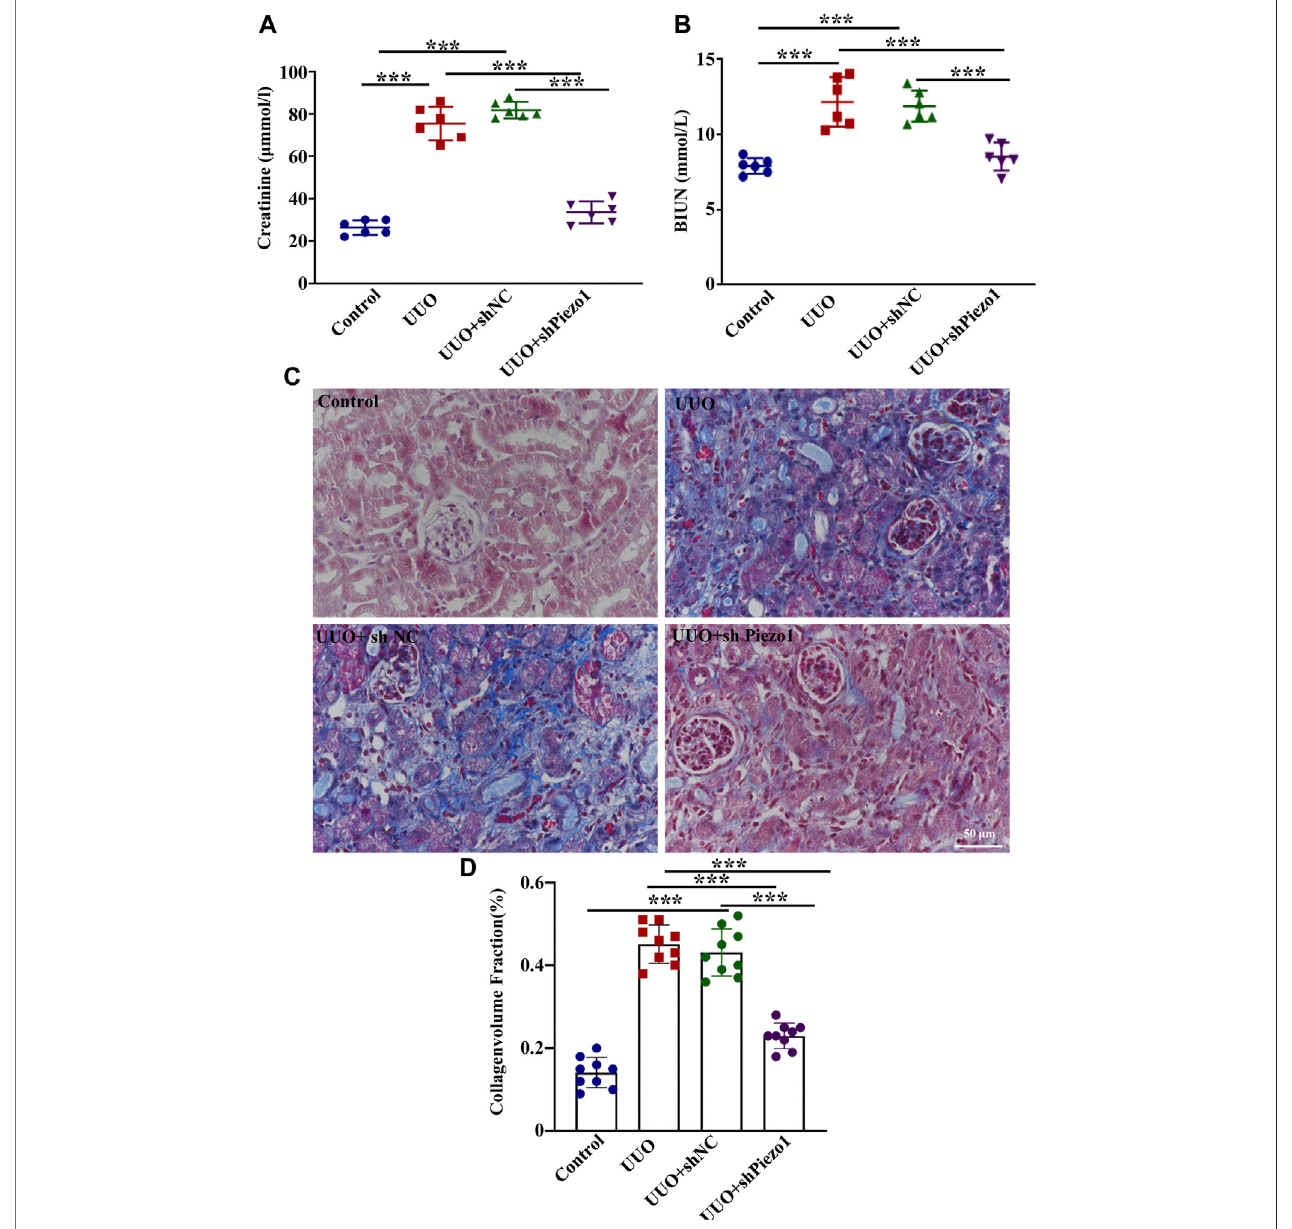
FIGURE 8 | Piezo1 knockdown improved renal function in UUO mice. An animal model of renal fi brosis induced by UUO was established and a loss-of-function experiment was carried out by using shRNA of Piezo1 and shNC in UUO mice. shNC refers to empty vector without Piezo1 shRNA. Renal function is assessed by (A) plasma creatinine and (B) BUN levels. ( n (cid:1) 6; * p < 0.05, ** p < 0.01, *** p < 0.001). (C) Masson staining reveals the excessive deposition of ECM (blue) in four different treatment groups. (D) The collagenvolume fraction in four different treatment groups (* p < 0.05, ** p < 0.01, *** p < 0.001).